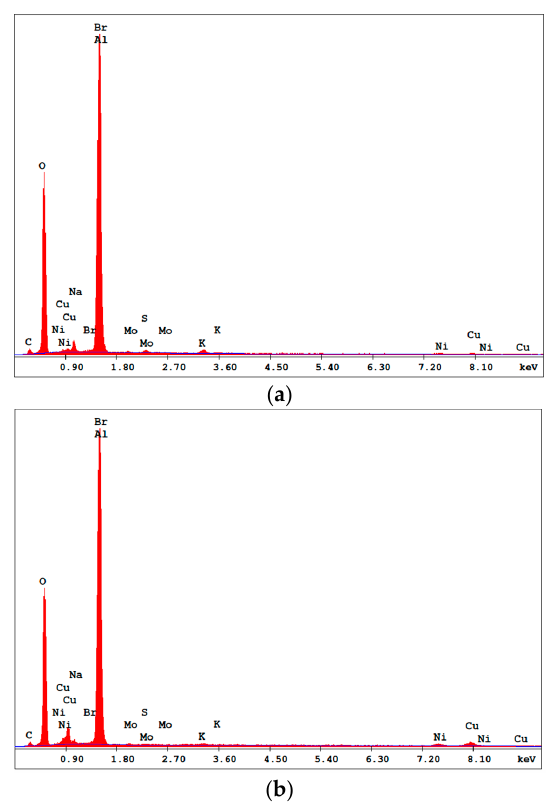
Figure 3. EDS spectrums of the ( a ) 30-min and ( b ) 60-min as-deposited electroless CuNiMoP/Al 2 O 3 .